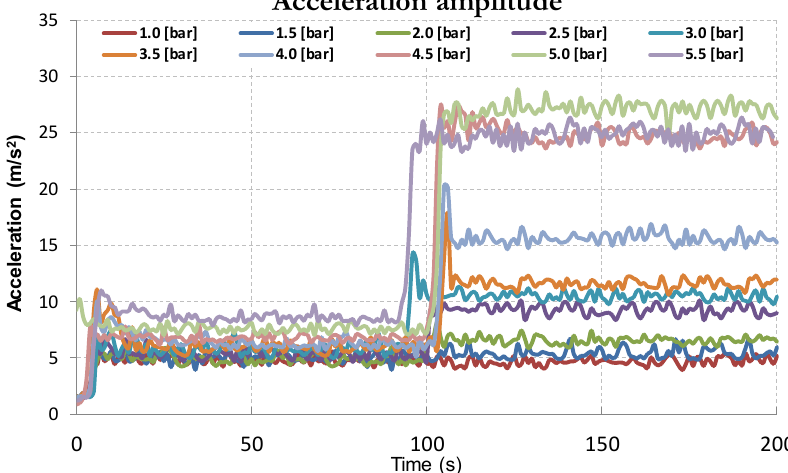
Figure 9. Influence of changes in tire pressure on vibrations of the drive unit.